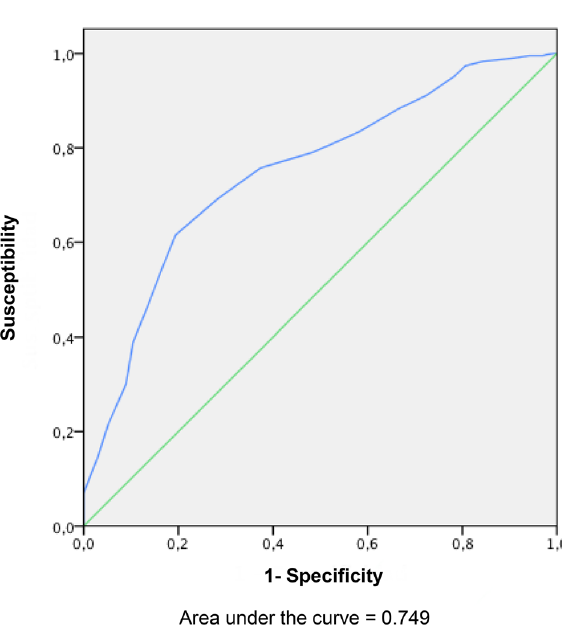
Figure 3. ROC curve obtained from the sum of the instrument scores at each feeding versus the feeding